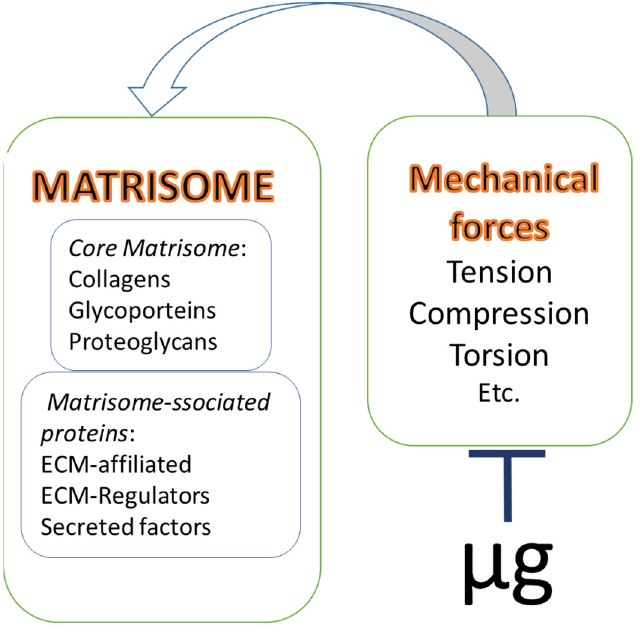
Figure 1. Matrisome and microgravity. According to the current concept an ensemble of ECM struc- tural (core) elements and ECM-associated proteins represents a complex structure called matrisome. The activity of matrisome elements is governed by different mechanical forces, strongly affected by microgravity (µg).